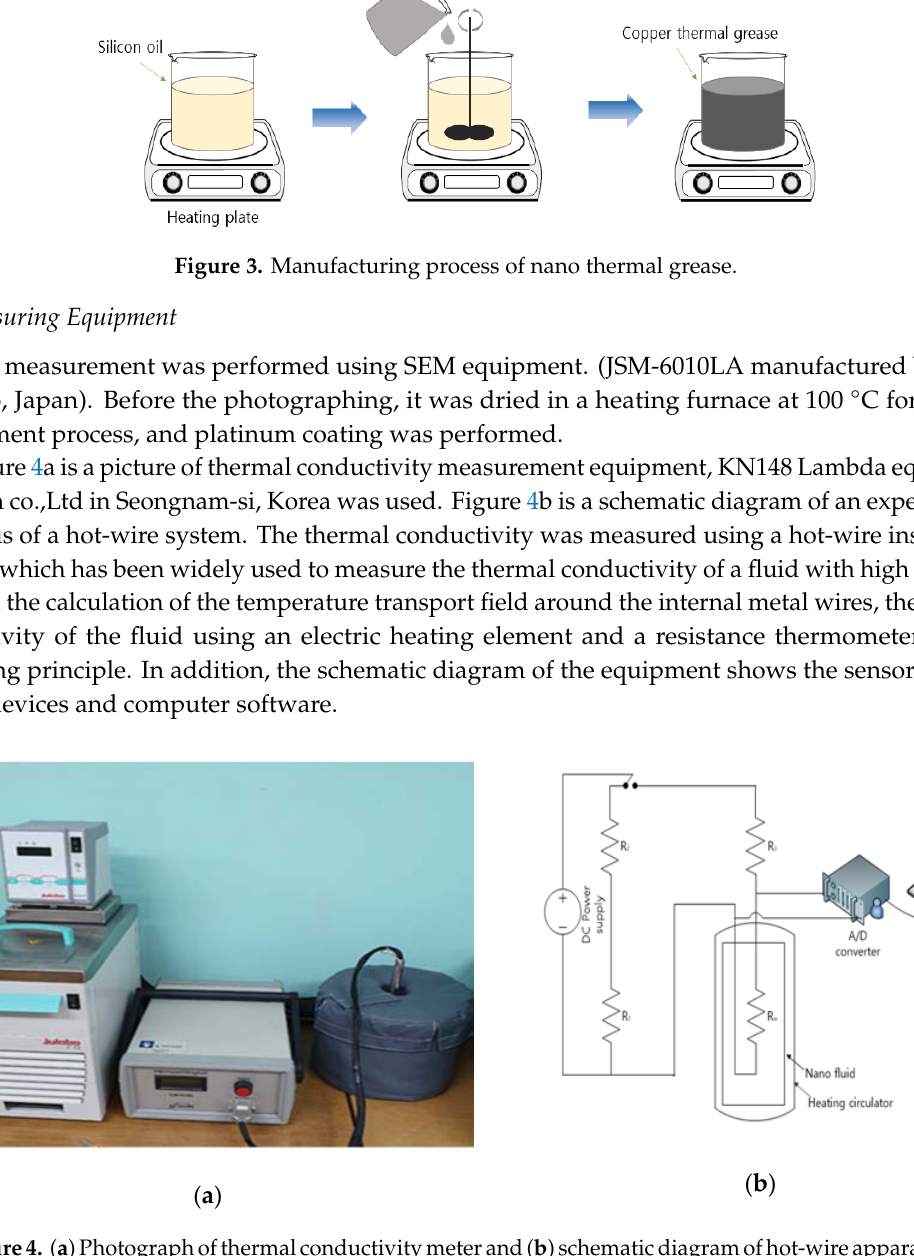
Figure 4. ( a ) Photograph of thermal conductivity meter and ( b ) schematic diagram of hot ‐ wire apparatus.